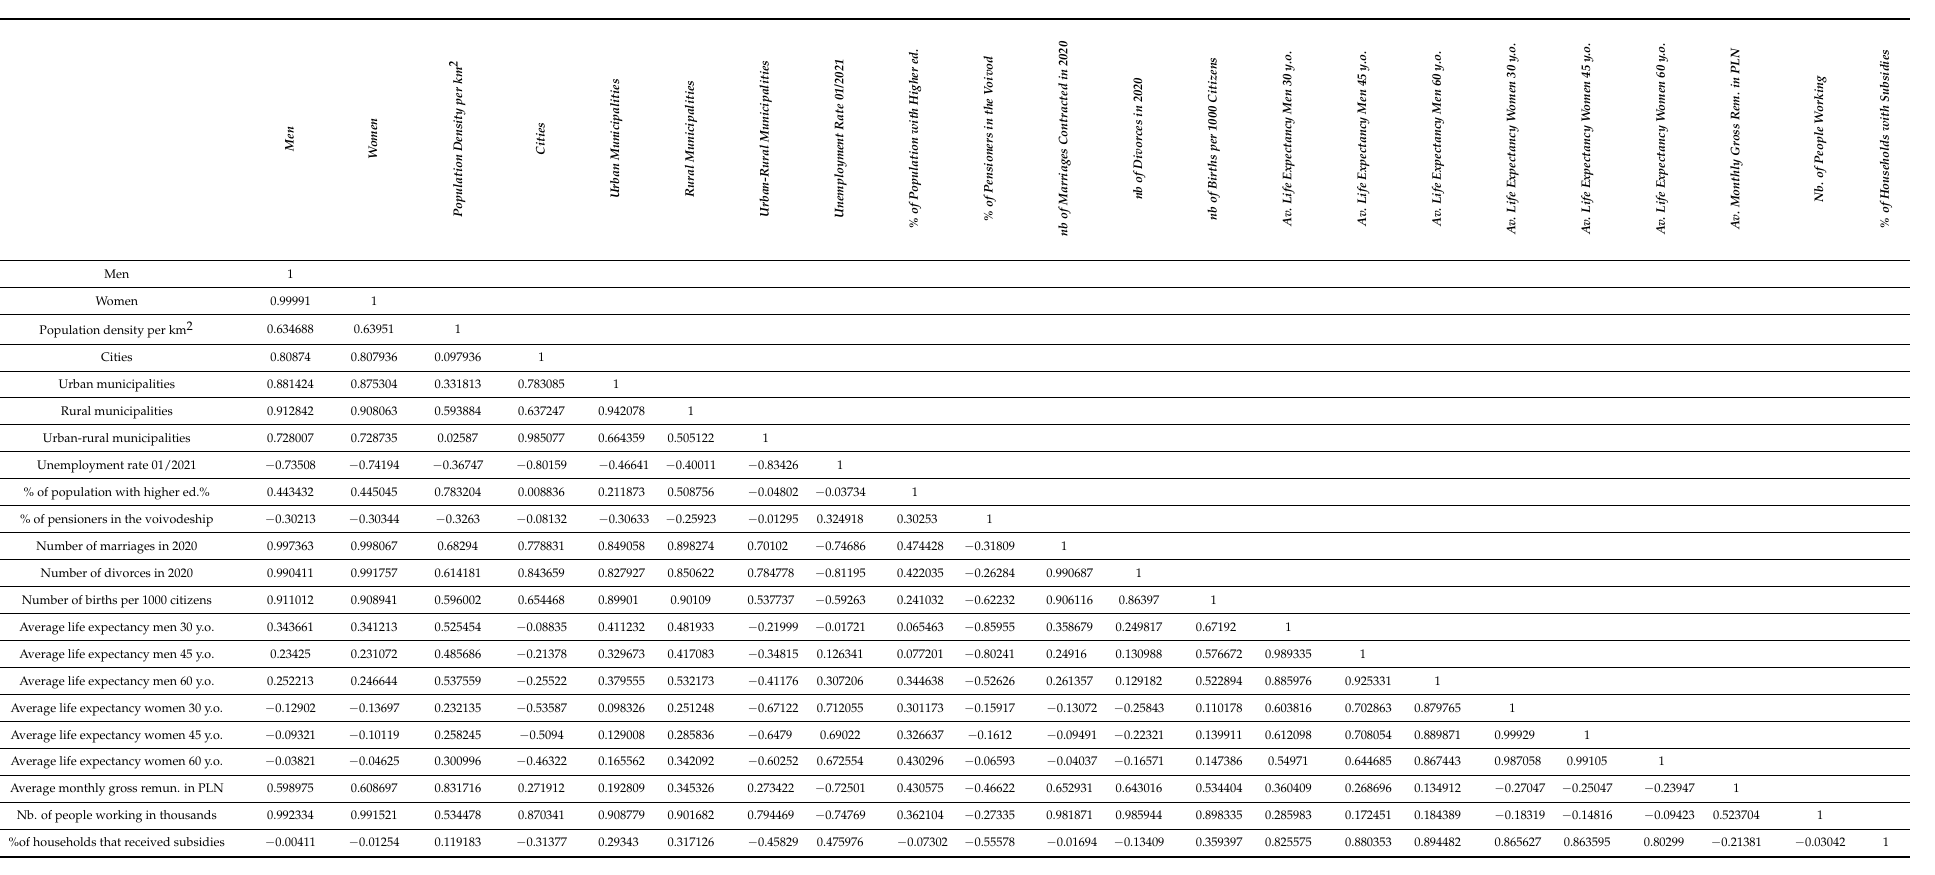
Table 3. The consumer profile correlation